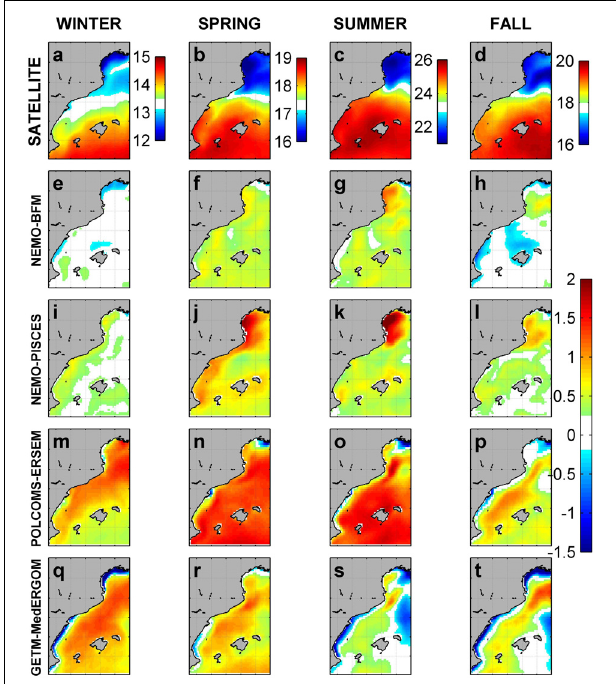
FIGURE 3 | Average seasonal SST from satellites and differences ( ◦ C) in SST between satellites and models. Satellite (a–d) , NEMO-BFM (e–h) , NEMO-PISCES (i–l) , POLCOMS-ERSEM (m–p) , and GETM-MedERGOM (q–t)